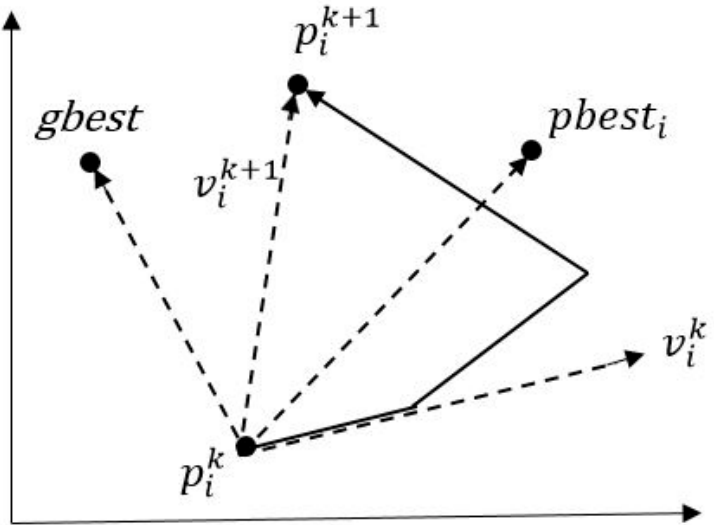
Figure 5. The updating process of velocity and position for each particle.